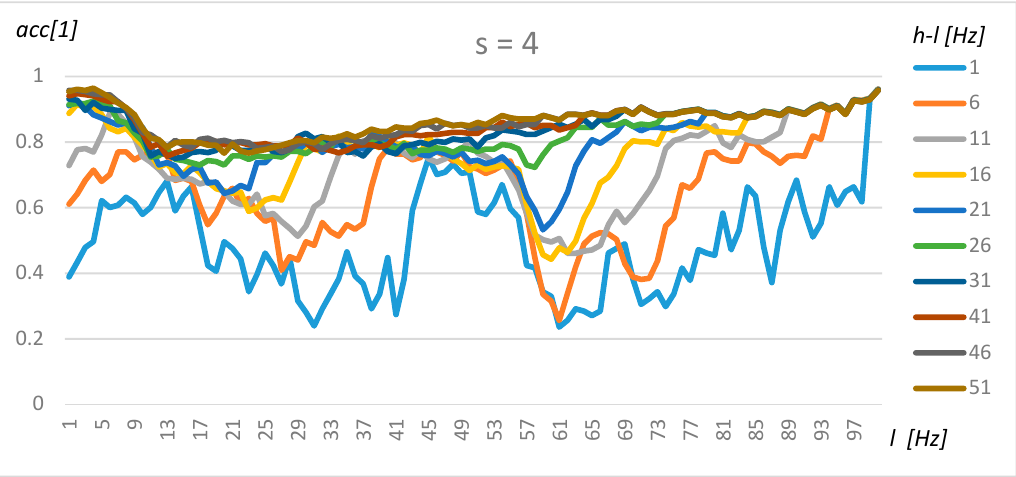
Figure 11. Exhaustive tuning method for resolution 0.5 Hz.